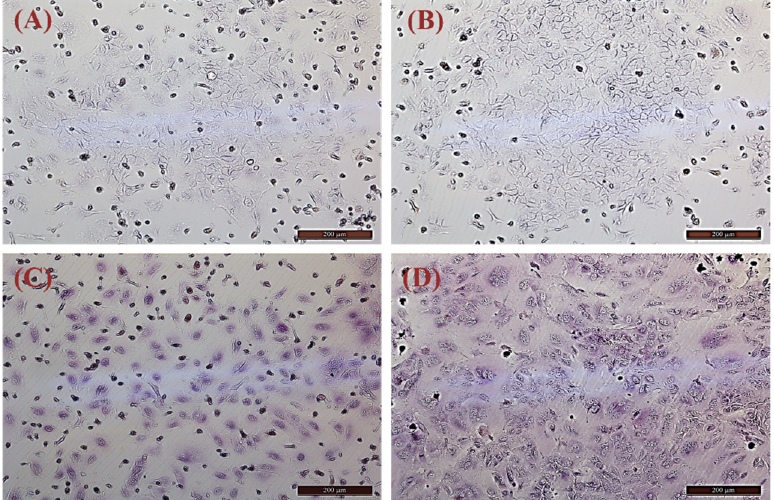
Figure 3. Primary hepatocytes subjected to PAS staining for glycogen (brightfield imaging). ( A , B ) Negative controls; ( C , D ) PAS staining of isolated cells. The isolated liver cells (cultured 6 days, passage 0) were assessed for hepatocyte- specific markers cytokeratin 18, AFP, and albumin using corresponding antibodies. Figure 4 shows that primary hepatocytes exhibited red or green fluorescence, and cell purity was at least 95% as determined by CK-18, AFP, and albumin